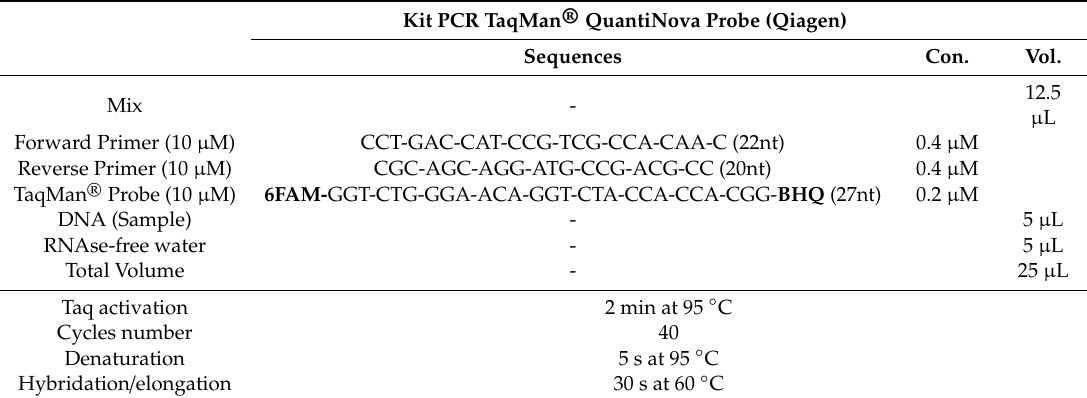
Table 3. Parameters of qPCR reagents and